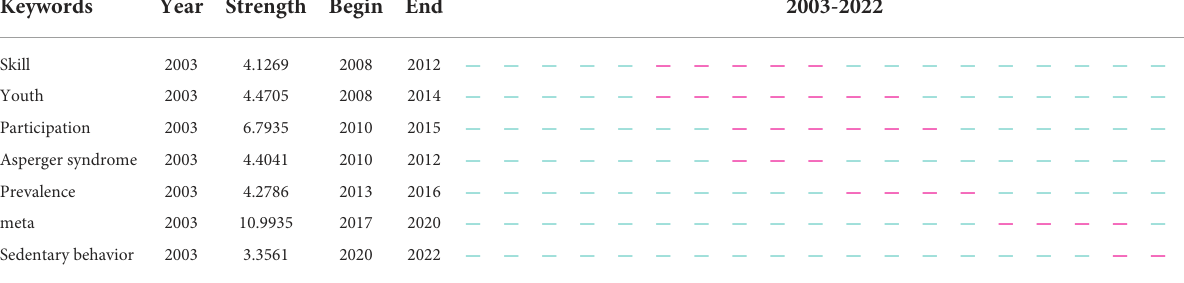
TABLE 5 Seven keywords with the strongest citation bursts